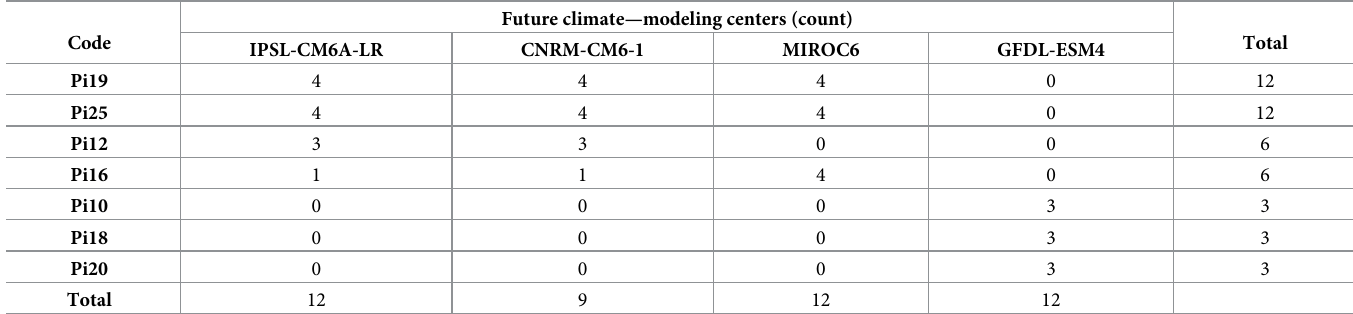
Table 6. Most frequent modelling centers for Pucaras that headed the first three positions of maximum erosion. Future climate—modeling centers Code